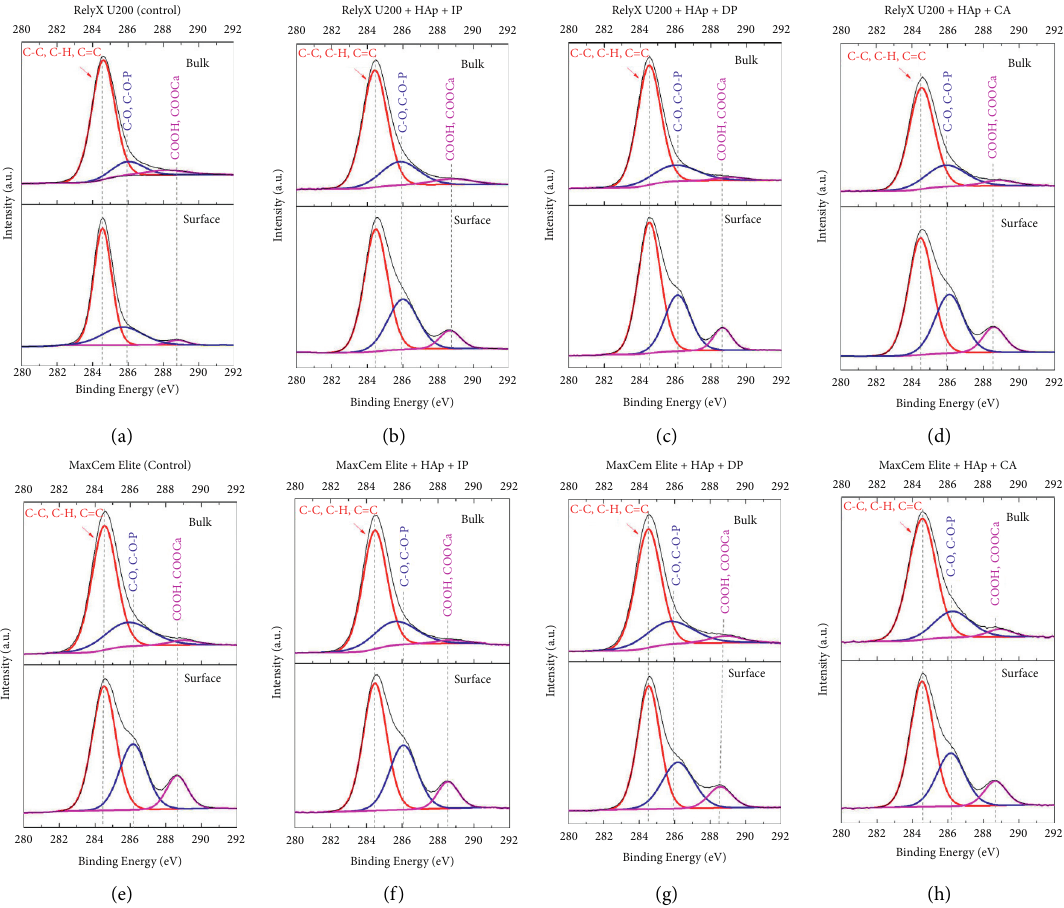
Figure 5: High-resolution C1s spectra of (a) RelyX U200 (control), (b) RelyX U200 +HAp+IP, (c) RelyX U200+ HAp+DP, (d) RelyX U200+HAp +CA, (e) Maxcem Elite (control), (f) Maxcem Elite +HAp+IP, (g) Maxcem Elite+HAp +DP, and (h) Maxcem Elite+HAp +CA. In each graph, the upper data are related to bulk spectra, while the bottom data are related to surface